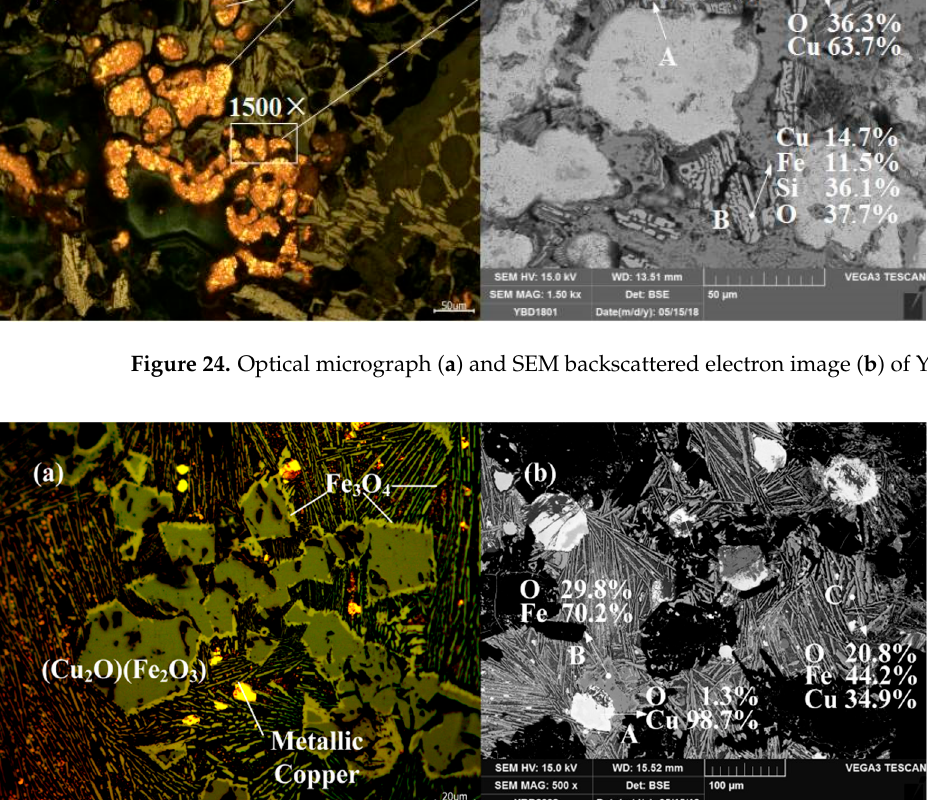
As shown in Figure 24.